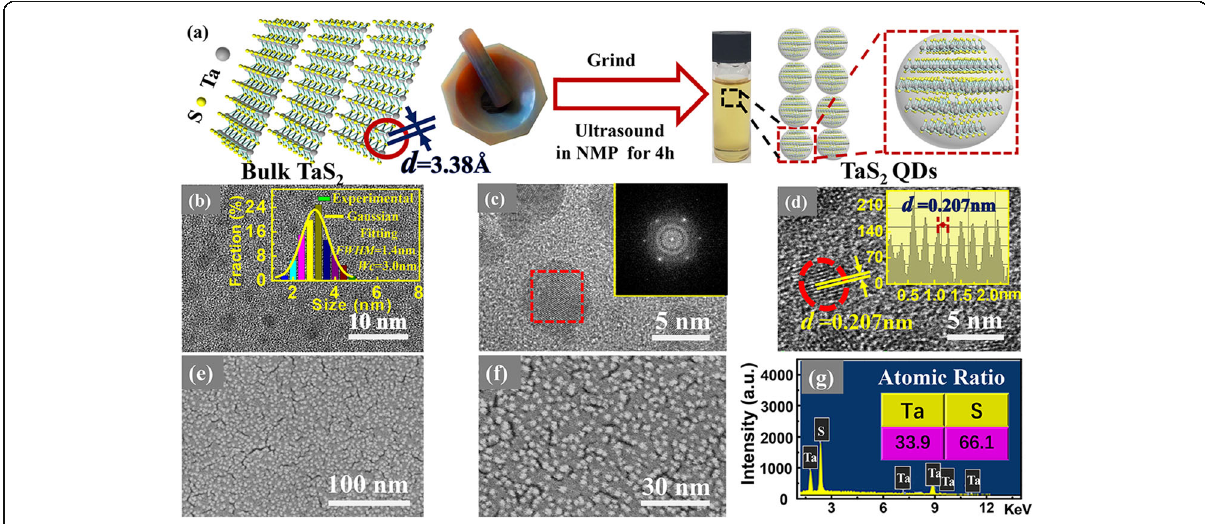
Fig. 1 a Schematic diagram showing the process of TaS 2 QDs formation; b TEM image of the TaS 2 QDs, inset shows TaS 2 QDs particle size distribution. Gaussian fitting curve is shown as yellow line; c FFT pattern (inset) of a selected area (dotted red square); d HR-TEM image of the TaS 2 QDs, inset shows the line profile of the diffraction fringes; e SEM image at 70.0 K; f SEM image at 100.0 K; g EDS spectrum of TaS 2